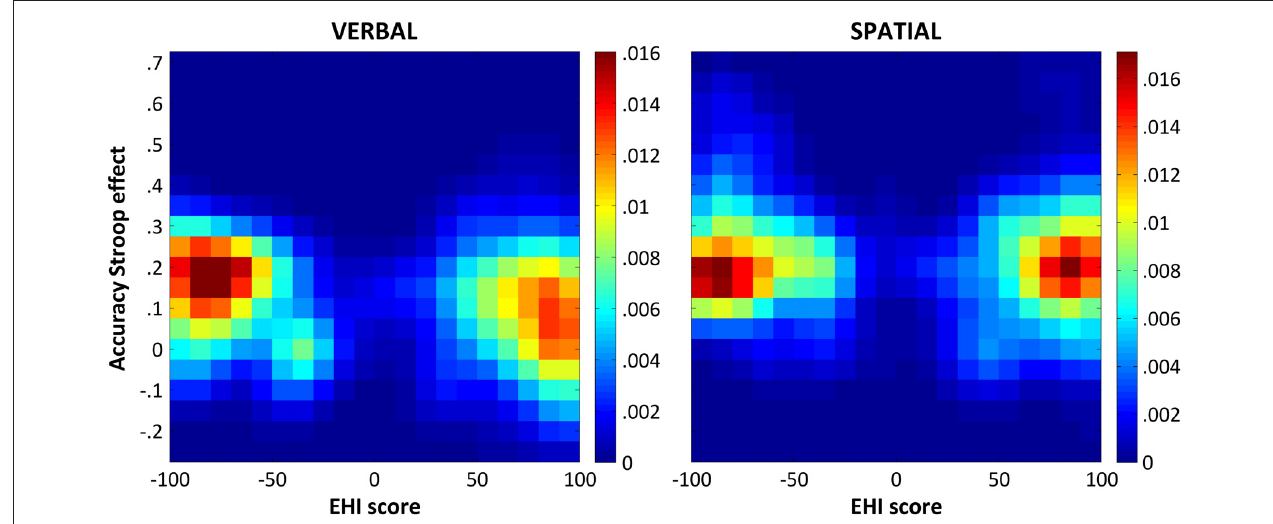
FIGURE 2 | Bivariate distributions of the accuracy Stroop effects and the EHI scores. The figure shows the bivariate distributions of the participants’ verbal (left panel) and spatial (right panel) accuracy Stroop effects ( y axis) as a function of their EHI scores ( x axis) as derived from 10,000 random subsets matching the number and EHI scores of participants with negative and positive EHI scores in our sample (see “Results” section for details). The bivariate distributions were smoothed with a Gaussian kernel with a full-width half-maximum of 2 × 2 bins, which corresponds to a Stroop effect of 0.1 and an EHI score of 10. The colorbars indicate probability